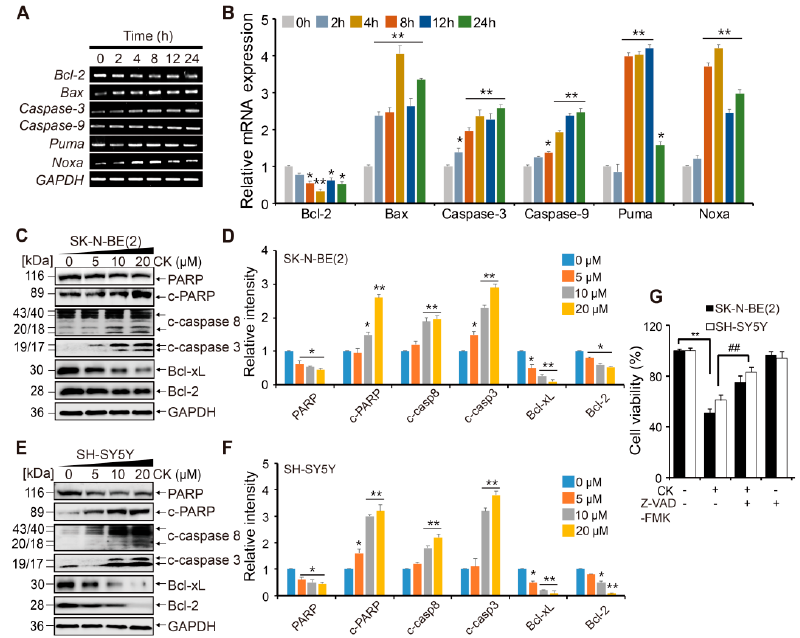
Figure 3. CK induces apoptotic cell death of human neuroblastoma cells. ( A ) mRNA expression levels of apoptotic genes, Bcl-2 , Bax , Caspase-3 , Caspase-9 , PUMA , and Noxa , were evaluated by